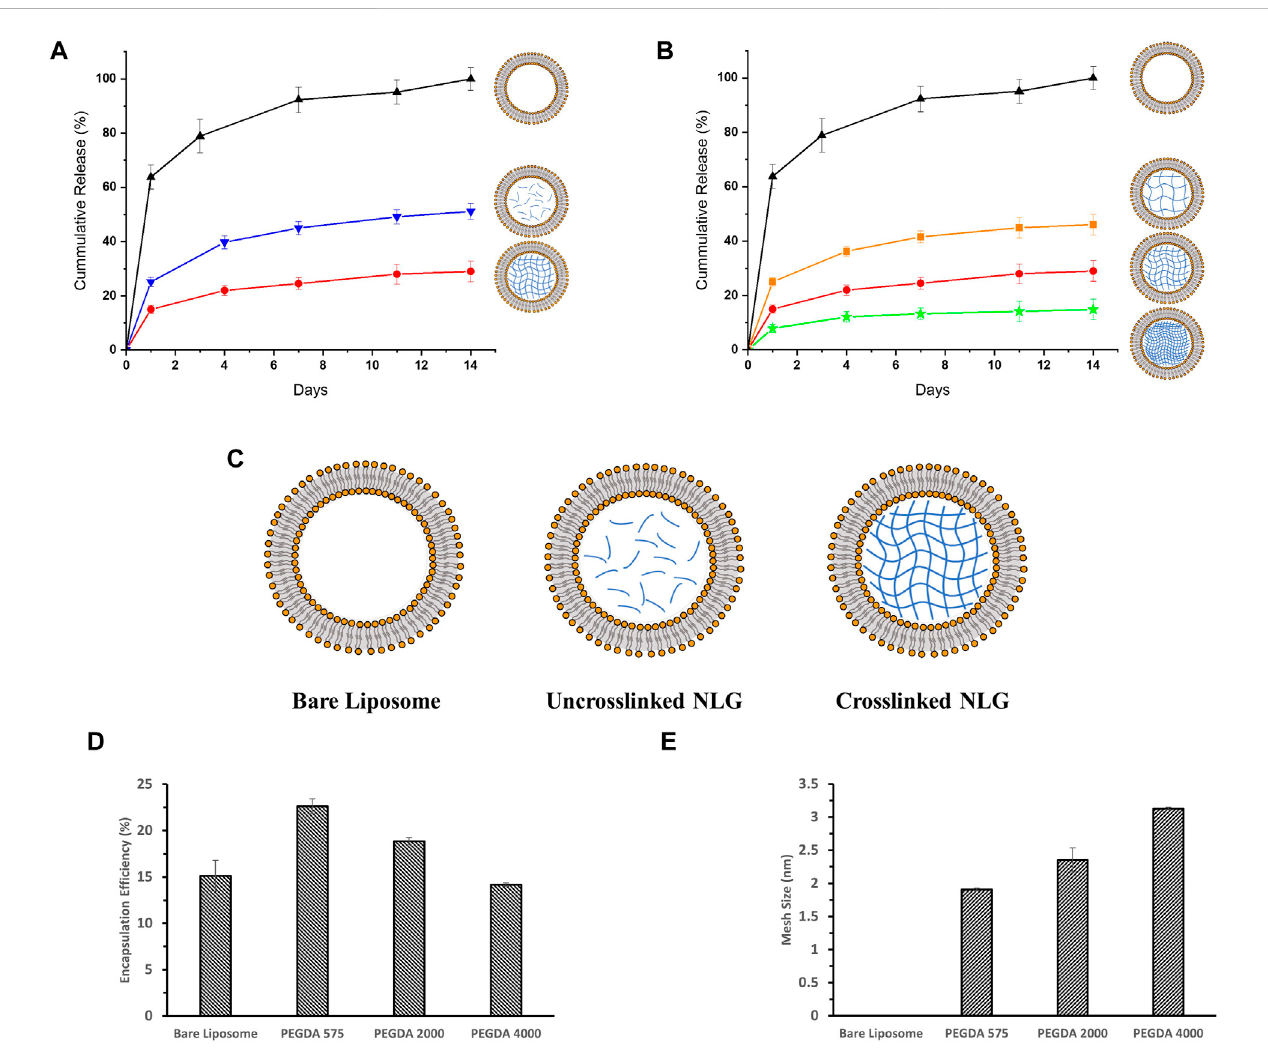
FIGURE 3 In-vitro release pro fi les for DFITC encapsulated in (A) Bare Liposome (Black, Triangle), Uncrosslinked PEGDA 2000 NLG (Blue, Inverted Triangle) and Crosslinked PEGDA 2000 NLG (Red, Circle), (B) Bare Liposomes (Black, Triangle), Crosslinked PEGDA 4000 NLG (Orange, Square), Crosslinked PEGDA 2000 NLG (Red, Circle) and Crosslinked PEGDA 575 NLG (Green, Star); (C) schematic showing the structural differences between Bare Liposome, Uncrosslinked NLG and Crosslinked NLG; (D) encapsulation ef fi ciency and (E) mesh size of each PEGDA